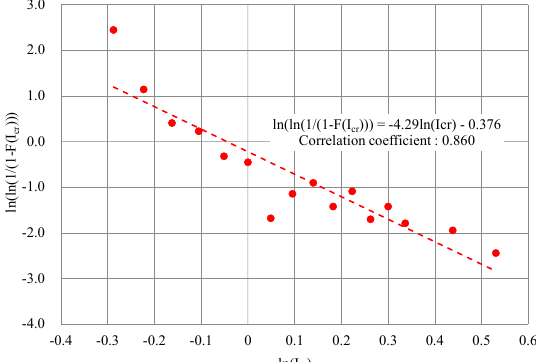
Figure 5. Relationship between thermal cracking index and thermal cracking probability.